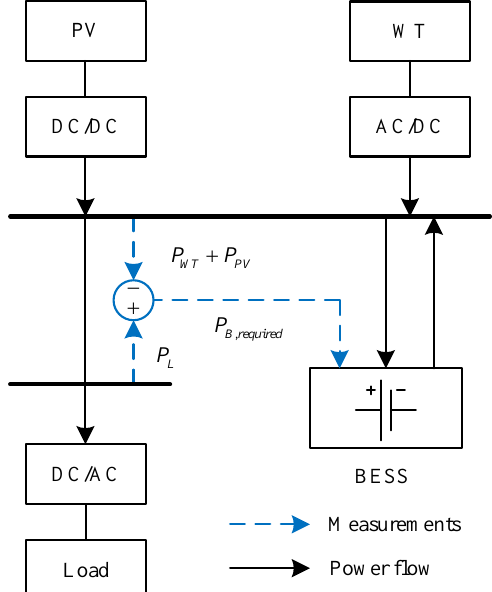
Figure 5. Schematic diagram of the standalone microgrid.